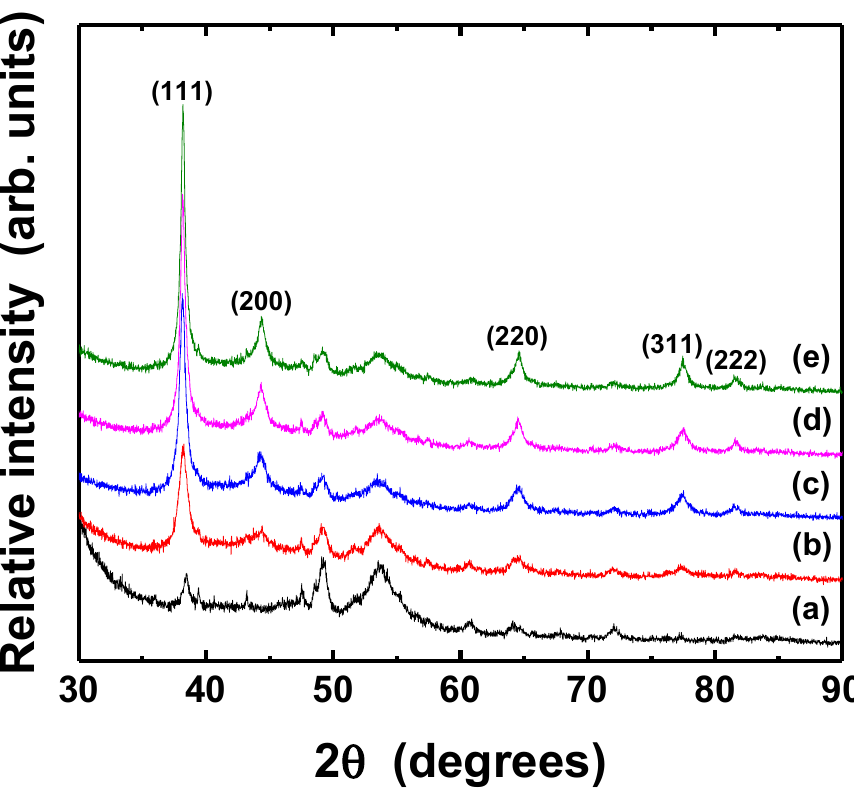
Figure 14. XRD patterns of Ag films irradiated for various durations: PET substrate ( a ), as-deposited ( b ), 10 min ( c ), 30 min ( d ), and 50 min ( e ), respectively. The wavelength and the light intensity of UV-LED module were 365 nm and 300 mW/cm 2 , respectively. Table 3. Grain size of Ag thin films photo-sintered at various light intensities and for different irra- diation durations. The wavelength of UV-LED module was 365 nm.